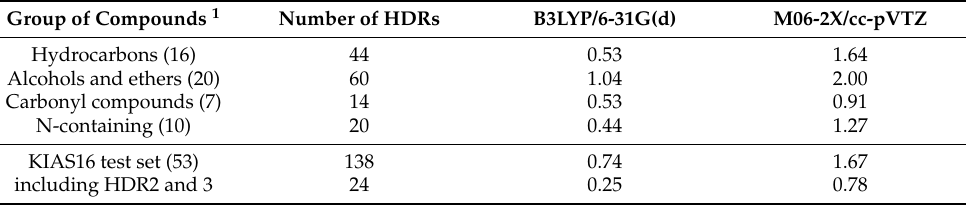
Table 1. DFT-calculated mean absolute heat capacity (MA ∆ C P , J/mol · K) for the HDRs of the KIAS16 test set, 298